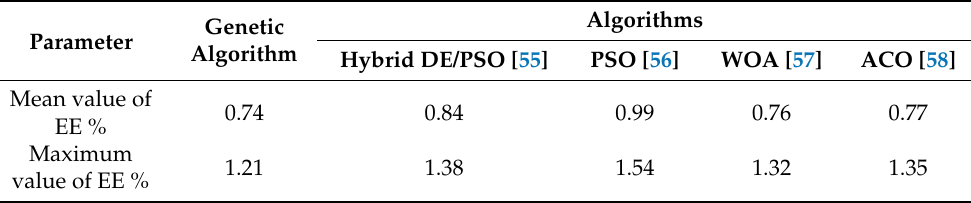
Table 6. Performance of different algorithms in solving a fault location